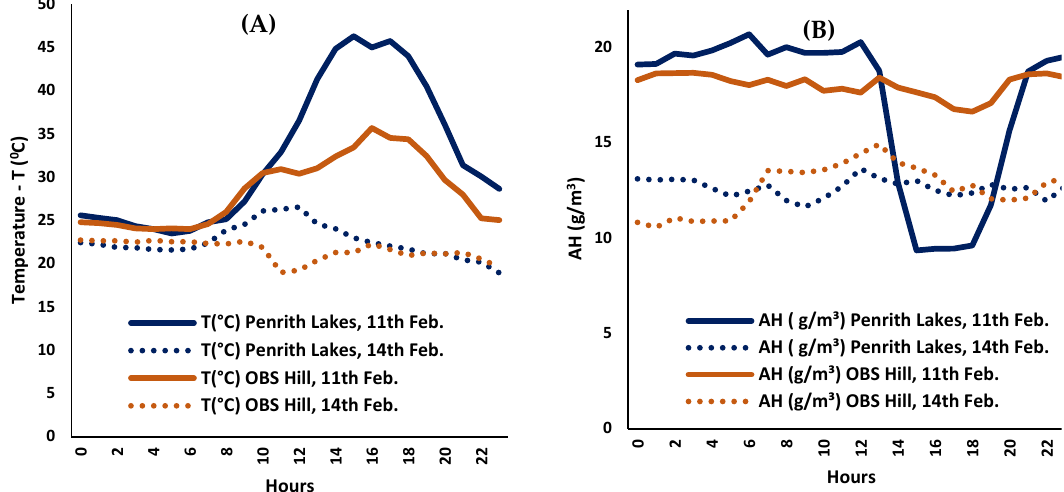
Figure 5. Temperature T ( ◦ C) and AH (g / m 3 ) profiles at Penrith Lakes & OBS Hill on selected HW (11 February 2017) & NHW (14 February 2017) days. ( A ) Temperature profiles in ◦ C at Penrith Lakes and OBS Hill on HW and NHW days, ( B ) AH profiles in g / m 3 at Penrith Lakes and OBS Hill on HW and NHW days.